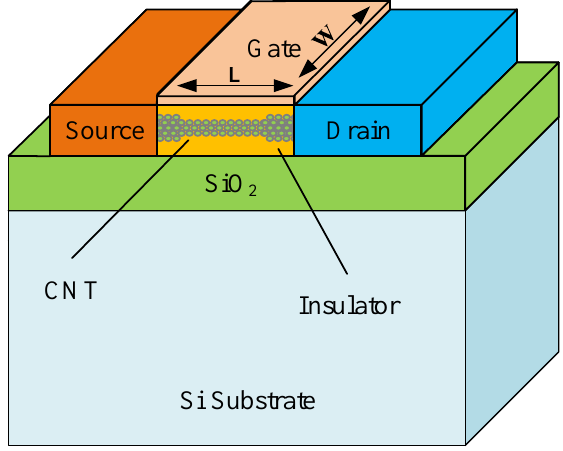
Figure 1. Device structure of a Carbon Nanotube Field Effect Transistor